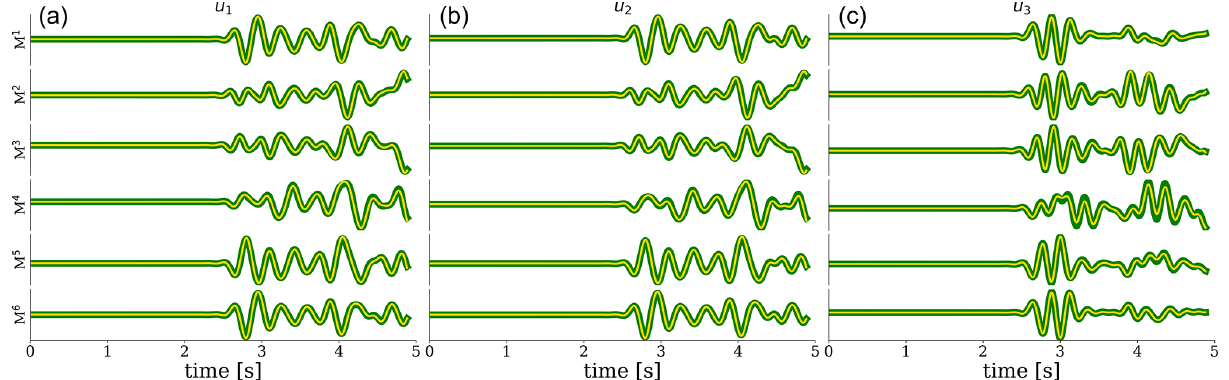
Figure 3. Comparison between elementary seismograms due to a source at the actual location (red star) and the receiver at G094 (green) as well as the elementary seismograms resulting from the implementation of source–receiver reciprocity (yellow). The equality of the traces confirms successful implementation of source–receiver reciprocity. Along the vertical axis, all six (independent) elementary seismograms are depicted. (a–c) Plots show particle displacement in the x 1 , x 2 , and x 3 direction,